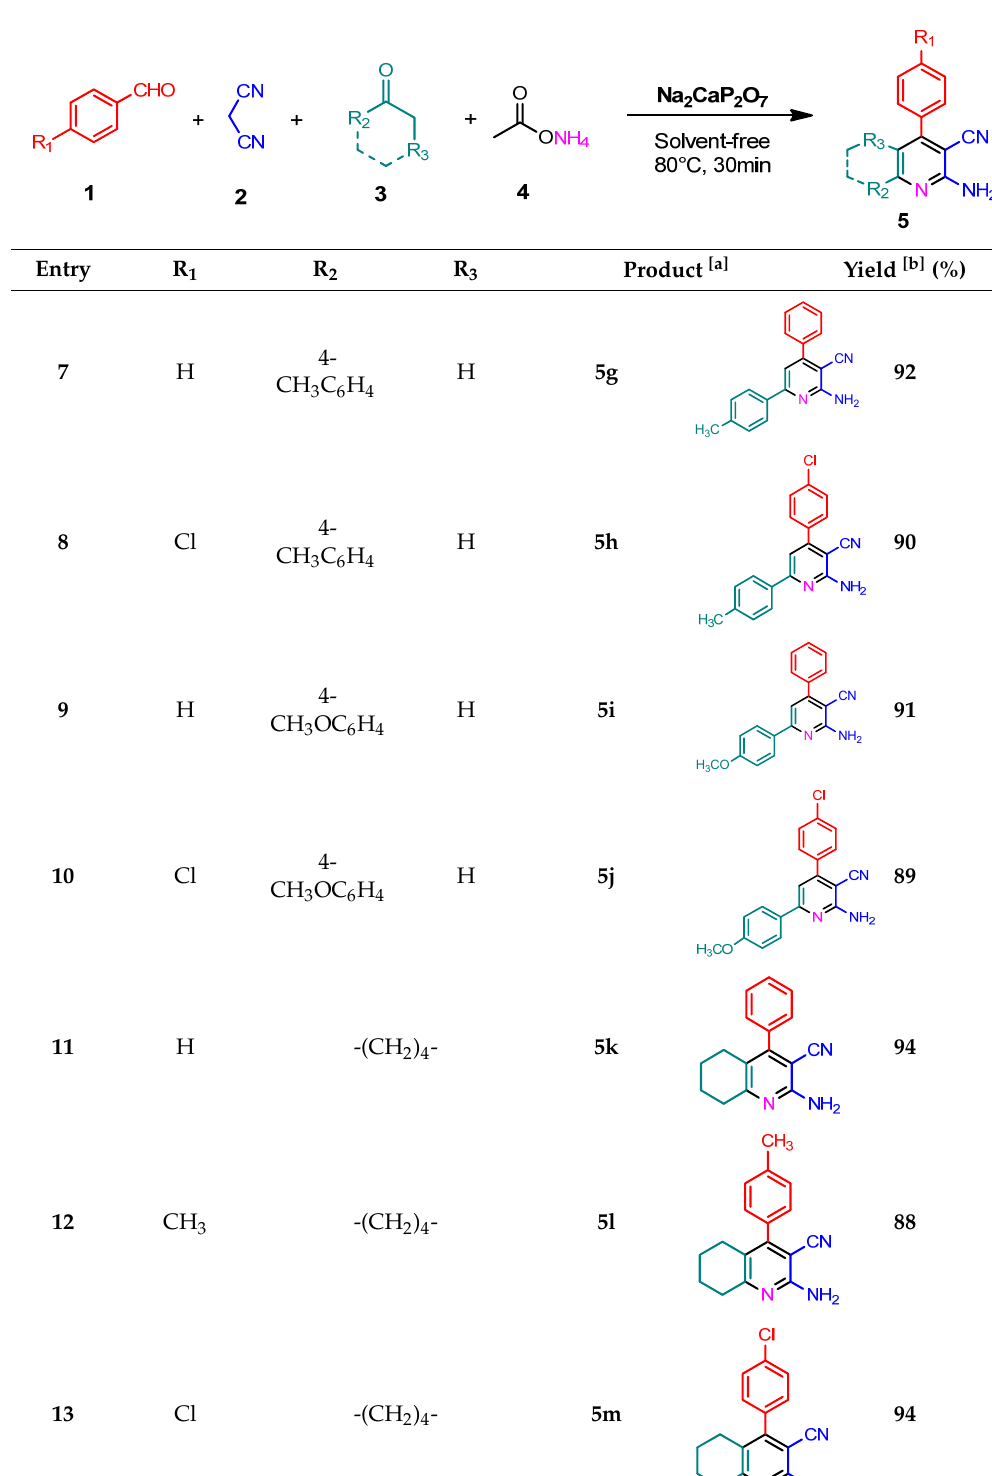
Table 2. Synthesis of 2-amino-3-cyanopyridine derivatives 5 Table 2. Cont.